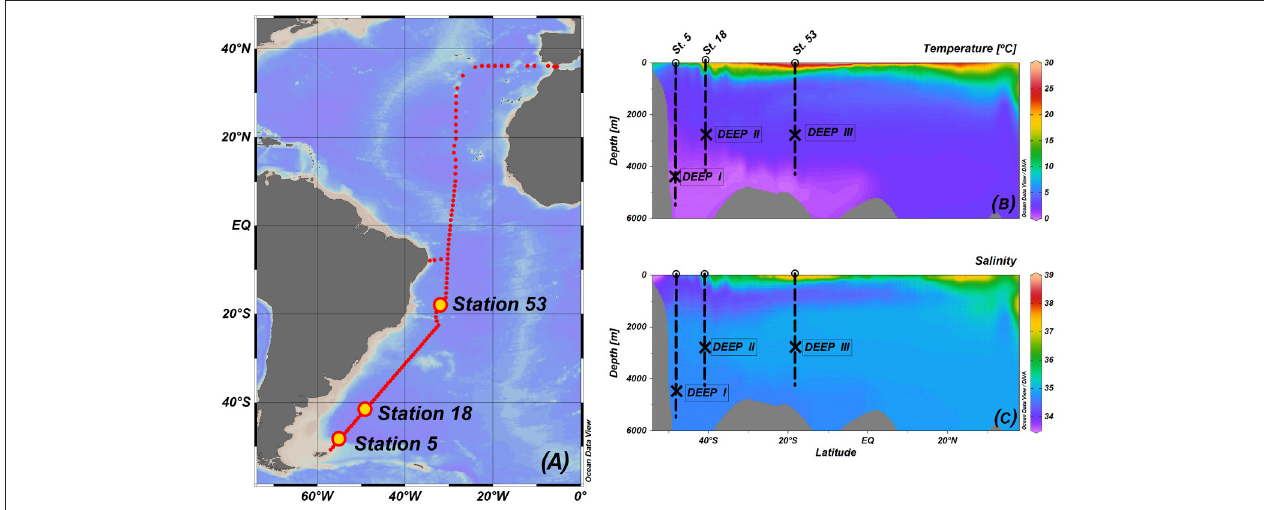
FIGURE 1 | Graphic summary of the XIVth FICARAM cruise: cruise track followed on board the Spanish R/V Hespérides (A), contour plot of temperature expressed in ◦ C (B), and contour plot of salinity (C). Panels include information about the sampling station and depths for each experiment. Ocean data View is used for mapping ( Schlitzer, 2015).